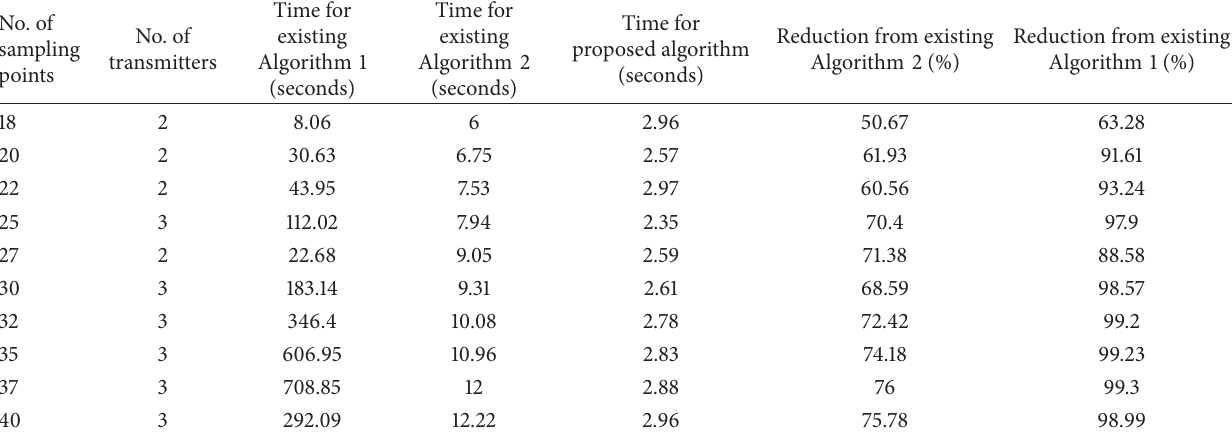
Table 5: Comparison among existing Algorithm 1, existing Algorithm 2, and proposed algorithm in terms of computation time.